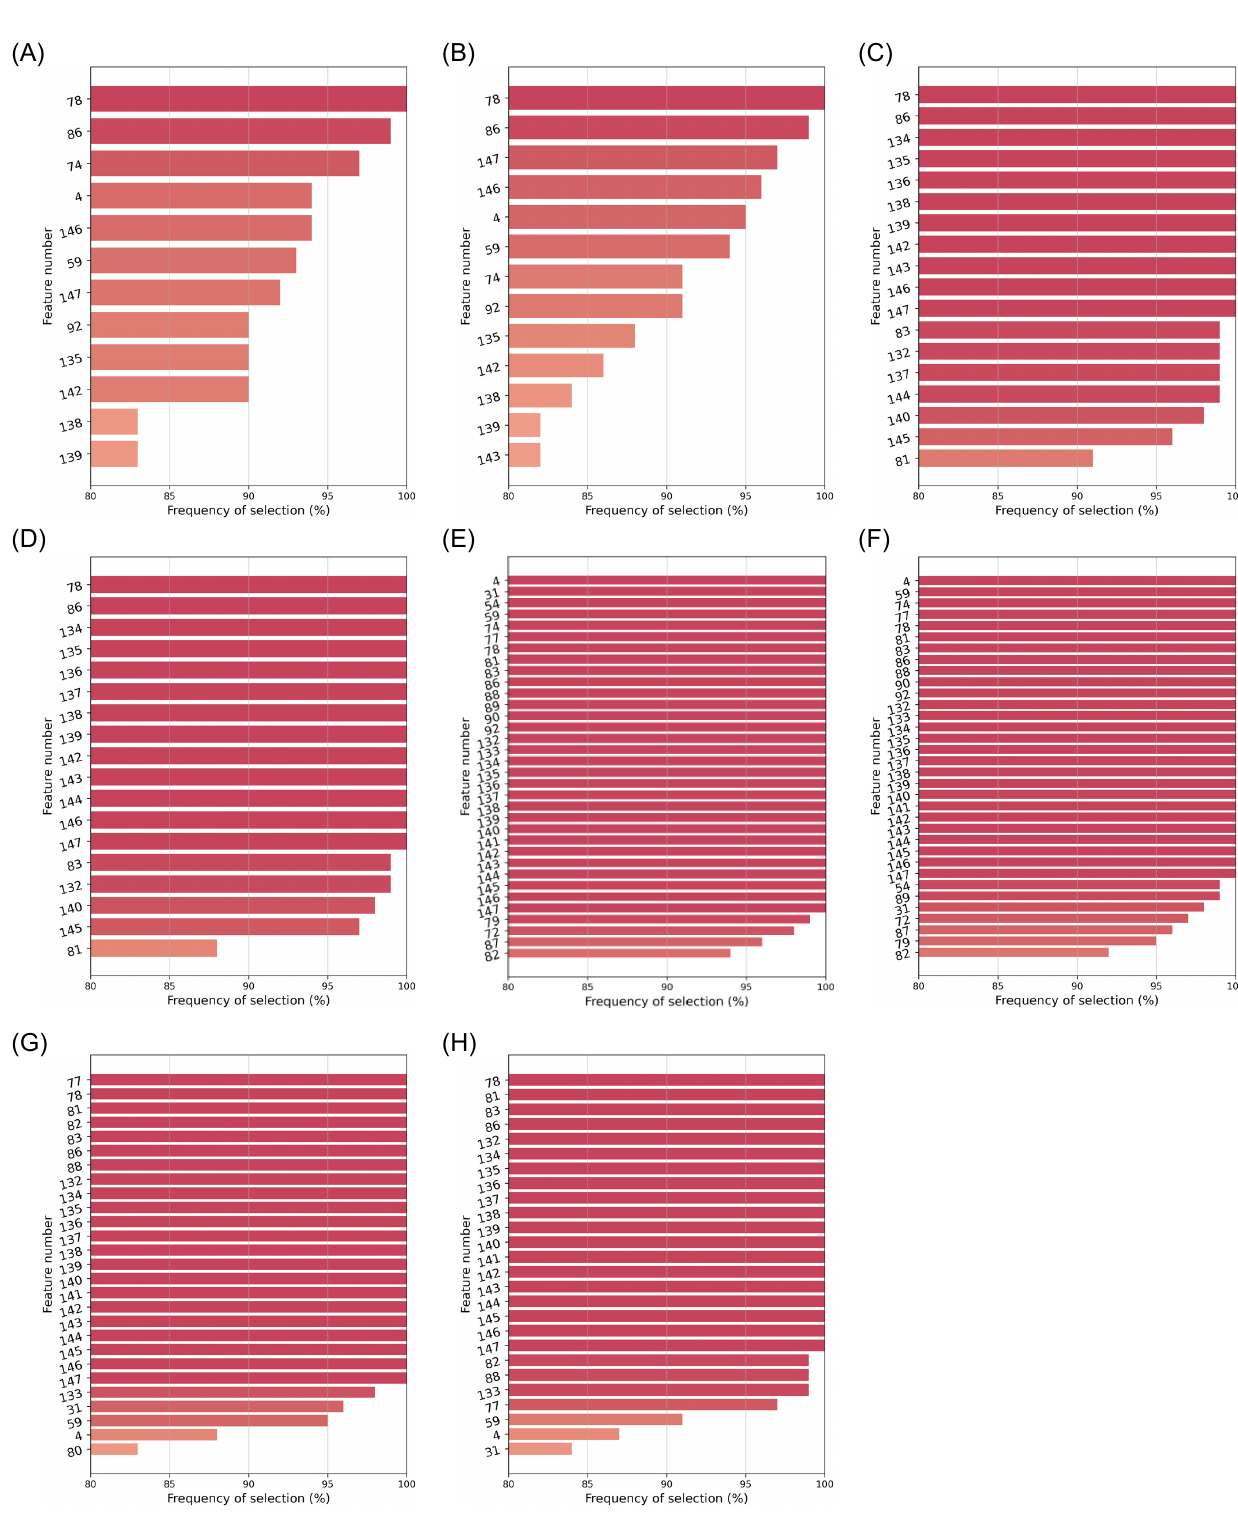
Fig 3. Features selected in ⩾ 80% cases by the stable MI filters: n 20. ( c ) MI Classif—iterat imputer: n FS = 20. ( d ) MI Regress—iterat imputer: n FS = 20. ( e ) MI Classif— k nn imputer: n FS = 40. ( f ) MI Regress— k nn imputer: n FS = 40. ( g ) MI Classif—iterat imputer: n FS = 40. ( h ) MI Regress—iterat imputer: n FS = 40.